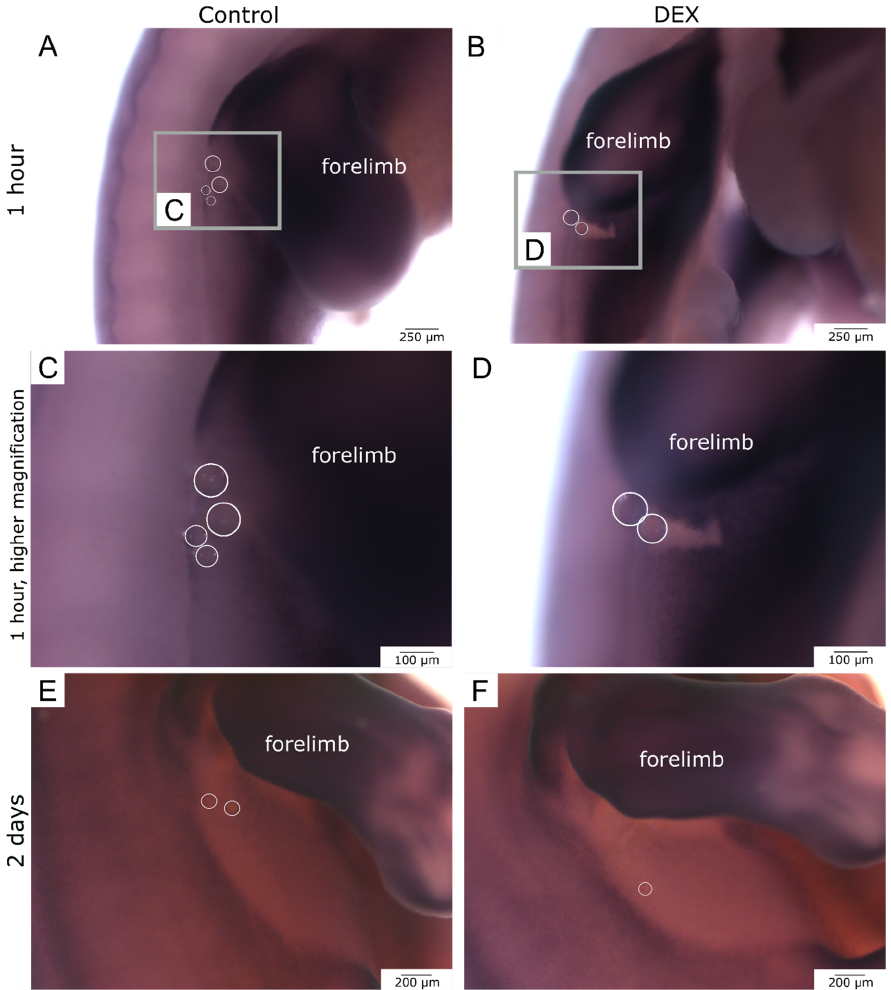
Figure 7. Dermo-1 expression in bead-implanted wounds. The images display the expression of Dermo-1 in the bead-implanted wounds. ( A ) shows a whole- mount of a hybridized control